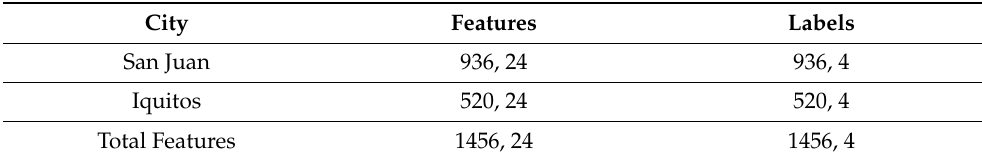
Table 4. Selected features for different cities.